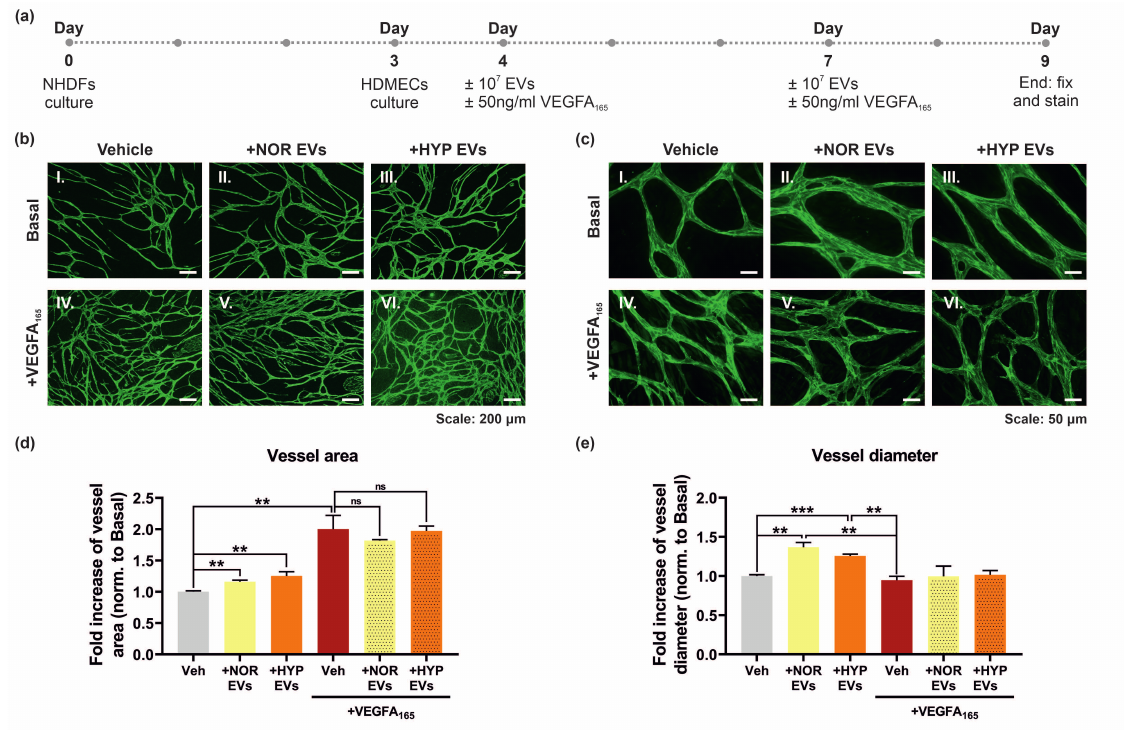
Figure 5. hUCMSC-derived EVs impact vessel formation in a fibroblast-endothelial co-culture angiogenesis model. ( a ) Normal Human Dermal Fibroblasts (NHDFs) were firstly plated as a feeding layer until confluent prior to the addition of HDMECs on day 3 in vitro. Cells were treated with 10 7 NOR/HYP hUCMSC-derived EVs and/or VEGFA 165 the day after adding HDMECs to the culture, and again 3 days after. Following 5 days of treatment, cells were fixed and immunostained with anti-VE-cadherin antibody and mounted. VE-cadherin fluorescence was detected to track vessel formation at both low ( b ) and high ( c ) magnifications (images from a representative experiment). ( d ) Total vessel area was quantified by AngioTool software. Data is presented as fold increase normalised to basal (data from 2 independent experiments, each ran in duplicate, n = 4, with 5–6 fields of view analysed per condition). ( e ) Average vessel diameter was quantified using REAVER analysis package. Data is presented as fold increase normalised to basal (data from 2 independent experiments, each ran in duplicate, n = 4, with 5–8 fields of view analysed per condition).